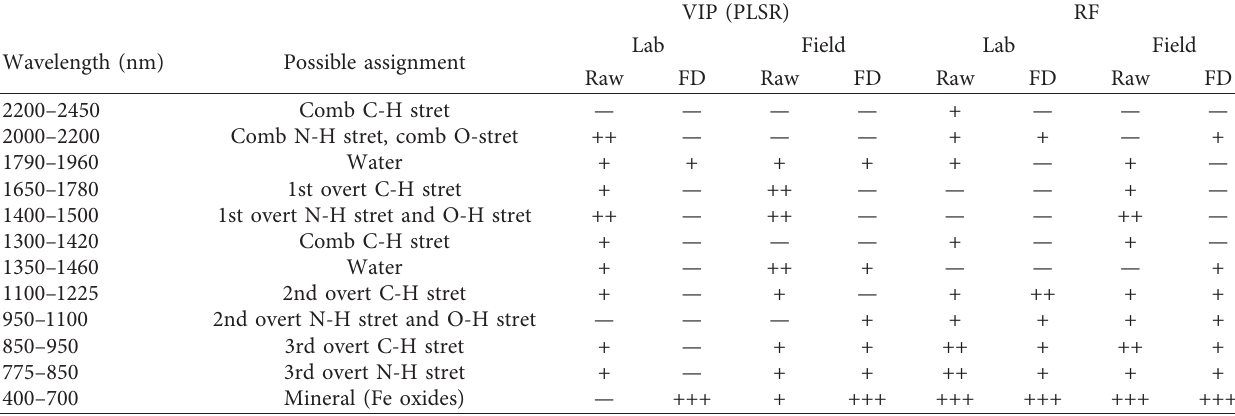
Table 2: Position of key wavelengths selected by both the VIP algorithm and the recursive feature selection method for all combinations of models.